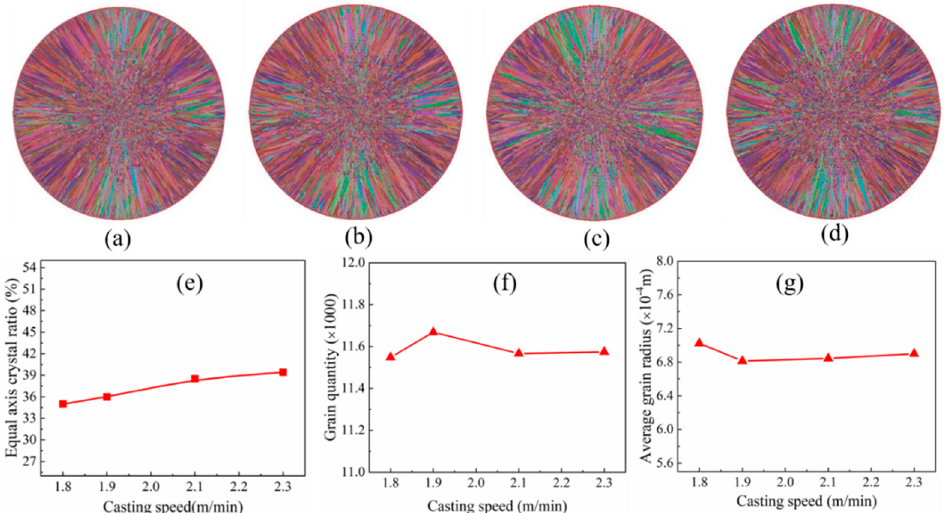
Figure 6. Influence of the casting speed on the solidification structure ( a – d ): solidification structure morphology at casting speeds of 1.8, 1.9, 2.1, and 2.3 m/min, respectively; ( e – g ): changes of equiaxed crystal ratio, grain number, and average grain radius with casting speed, respectively.